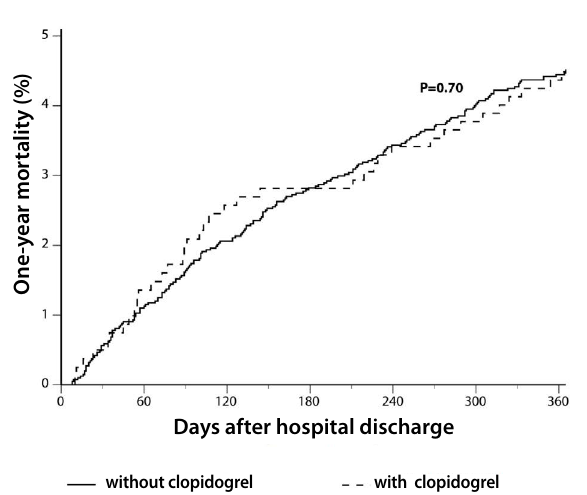
Fig. 1 – One-year mortality according to the clopidrogel use after CABG.